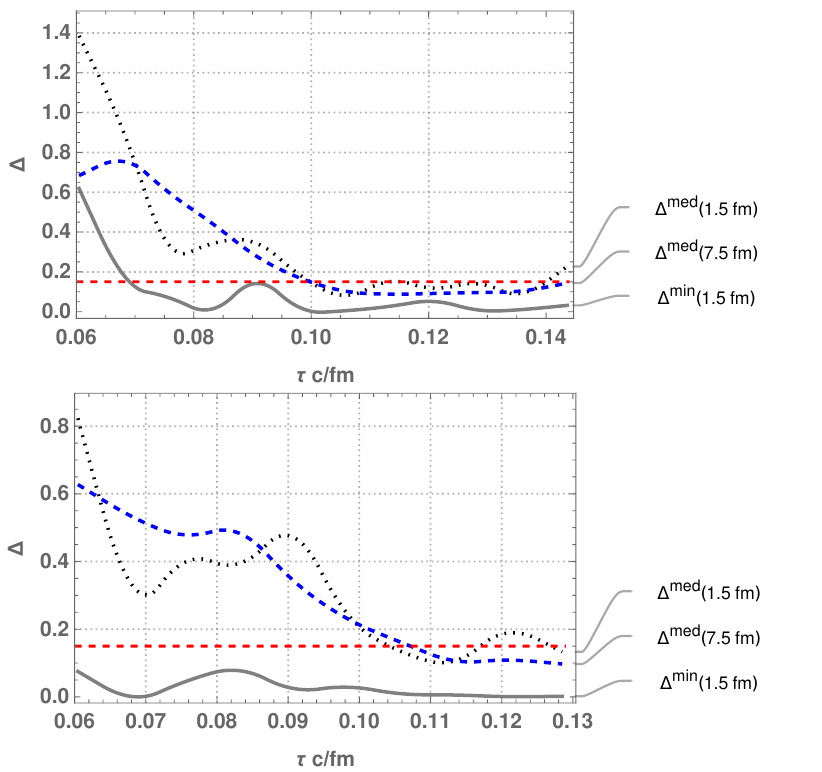
Figure 7 . In the top plot we show the median hydro residual at rapidity ξ = 0 . The red dashed line corresponds to ∆ = 0 . 15 . The black dotted line shows the residual averaged over the central region | x ⊥ | < 7 . 5 fm, whereas the blue dashed curve shows the same for | x ⊥ | < 1 . 5 fm. The gray line shows the minimal ∆ in the region | x ⊥ | < 1 . 5 fm. The plot below depicts the analogous functions at rapidity ξ = 0 . 25 .